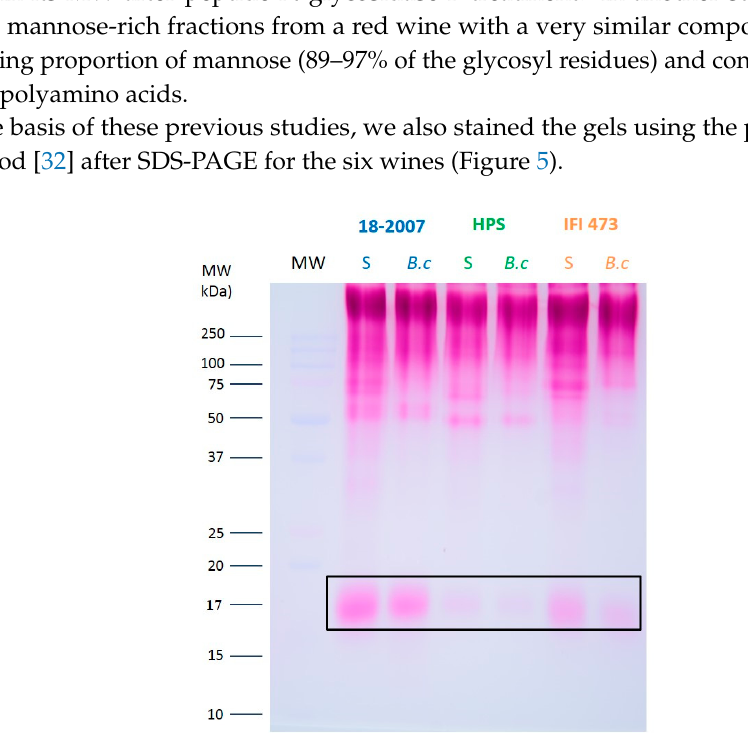
Figure 5. One-dimensional SDS-PAGE analysis of the secreted proteins from the enological Figure5. One-dimensionalSDS-PAGEanalysisofthesecretedproteinsfromtheenological Saccharomyces Saccharomyces strains 18-2007, HPS, and IFI473. The wines were concentrated 45× for the PAS staining. strains 18-2007, HPS, and IFI473. The wines were concentrated 45 × for the PAS staining. Relative Relative molecular weights (MW) from standards are given on the left side of the gels. molecular weights (MW) from standards are given on the left side of the